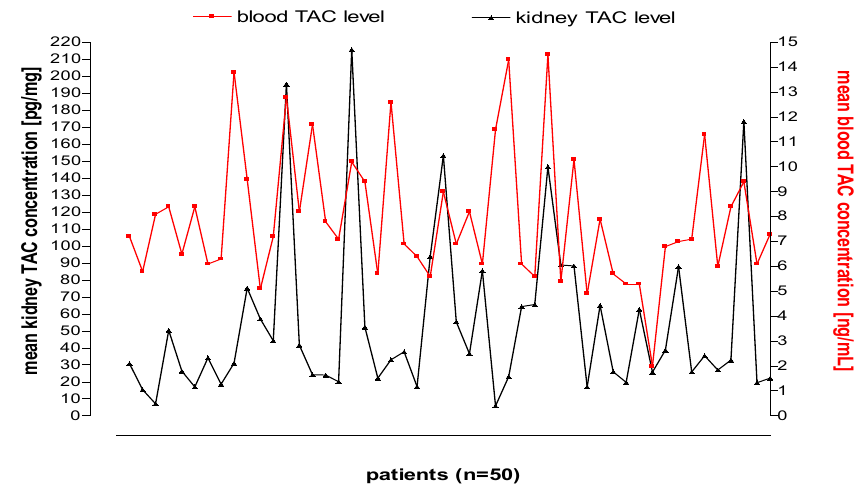
Figure 3. Kidney tissue and blood TAC levels determined in 50 transplant patients.